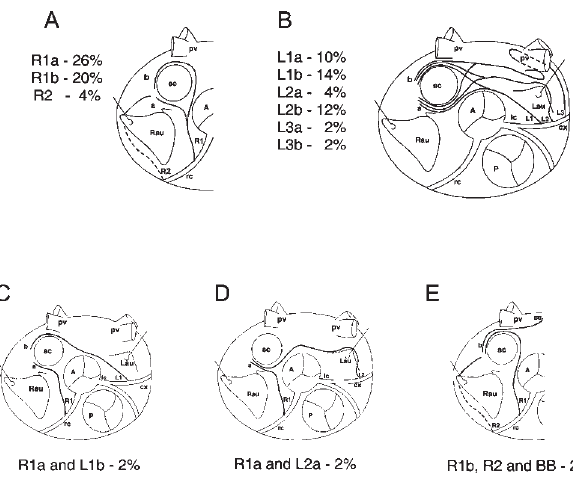
Figure 1 - Schematic representation of the route types of the sinuatrial node branch (NB) and its frequency. A . Types of the right side. B. Types of the left side. C, D . With 2 NB, 2 types, respectively: R1 a , L1 b and R1 a , L2 a . E . With 3 NB: 1 type R1 a , other type R2 and the third branch probably originated from the bronchial branch of the thoracic aorta